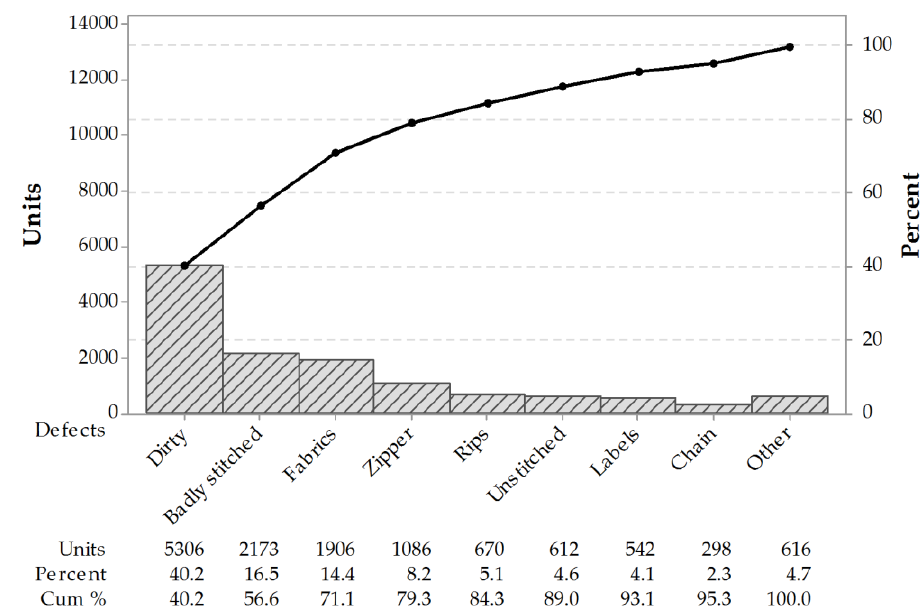
Figure 2. Pareto diagram of defects in the enterprise.